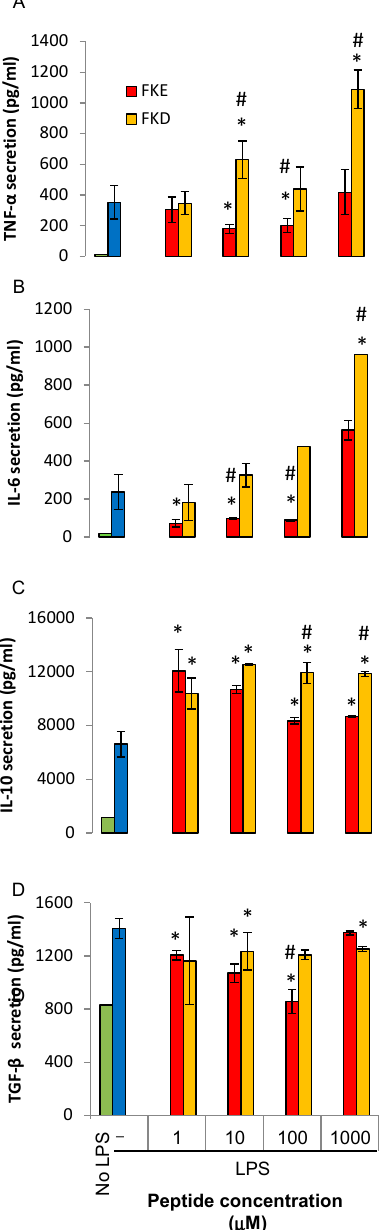
Figure 3. Lf-derived peptides regulate LPS-induced cytokine secretion from human macrophages. U937-derived macrophages were treated with FKE or FKD peptides (0.1–1000 µ M) for 24 h and then treated with LPS (100 ng/mL, 24 h). Next, culture media was collected and its cytokine content was determined by standard ELISA for TNF- α ( A ), IL-6 ( B ), IL-10 ( C ) or TGF- β ( D ). Results are representative from five experiments with biological and analytical duplicates for each treatment and are presented as mean ± SD. * and # indicate p < 0.05 compared to treatment with LPS alone or with other peptide, respectively. All treatments were statistically di ff erent from untreated cells, except cells treated by LPS and 100 µ M FKE in (D)